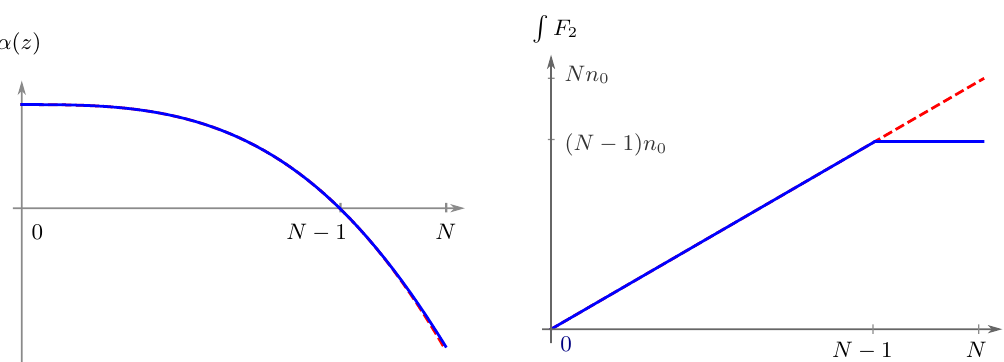
Figure 4. Left: α ( z ) for the massive theory (red, dashed) and the corresponding orbi-instanton (blue, solid) obtained via Hanany-Witten moves. The two graphs overlap for z ∈ [0 , N ] and diverge slightly in the interval [ N − 1 , N ] . Right: integral R F of the two-form RR flux for the massive (red, 2 dashed) and massless (blue, solid)